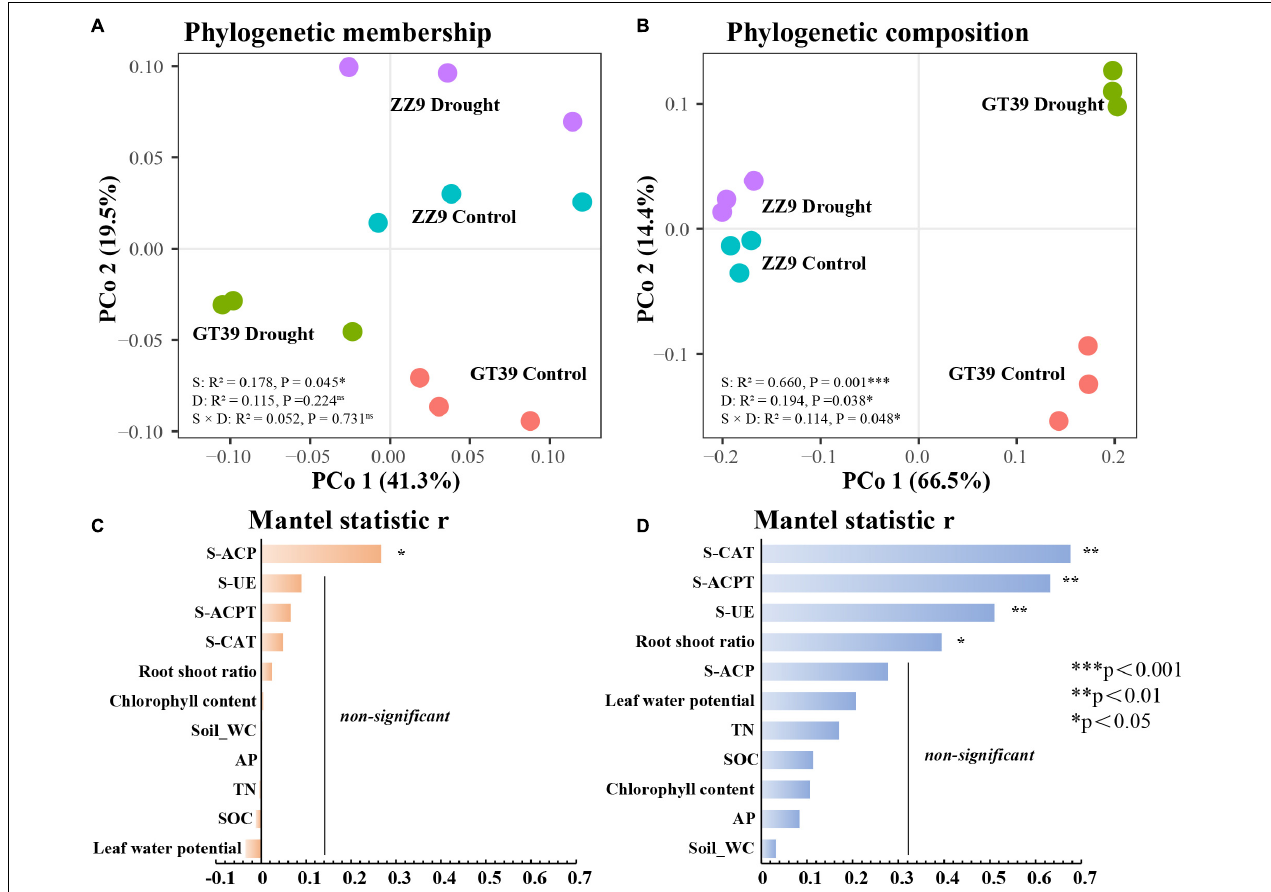
FIGURE 2 | PCoA analysis of beta diversity based on Unifrac distance. (A) PCoA analysis of β diversity based on unweighted UinFrace distance, where PCo1 axis shows the effect of water treatment, and PCo2 represents the effect of variety differences on microbial community β diversity. (B) PCoA based on weighted UniFrac distance According to the analysis, the PCo1 axis shows the main influencing factors, and the PCo2 represents the effect of water treatment on the microbial community β diversity. (C,D) Correlation between environmental factors and correlation between bacterial beta-diversity and environmental factors in two sugarcane cultivars using Mantel test. (C) Mantel statistic analysis of the correlation between β diversity of ZZ9 varieties and environmental factors. (D) Mantel statistic analysis of the correlation between β diversity of GT39 varieties and environmental